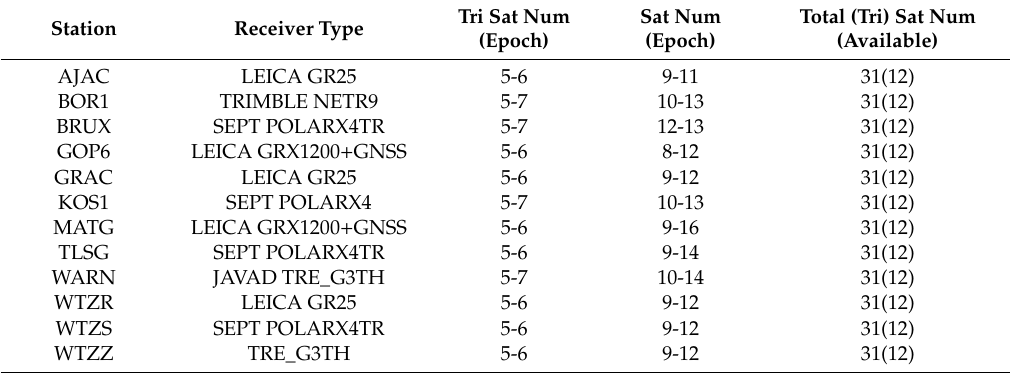
Figure 2. Distribution of selected stations with GPS triple-frequency observations. Table 2. Information of the twelve user stations including receiver type, the number of visible triple-frequency GPS satellites per epoch (Tri Sat Num), the number of visible GPS satellites per epoch (Sat Num), the total number of available GPS satellites and available triple-frequency GPS satellites (Total (Tri) Sat Num).